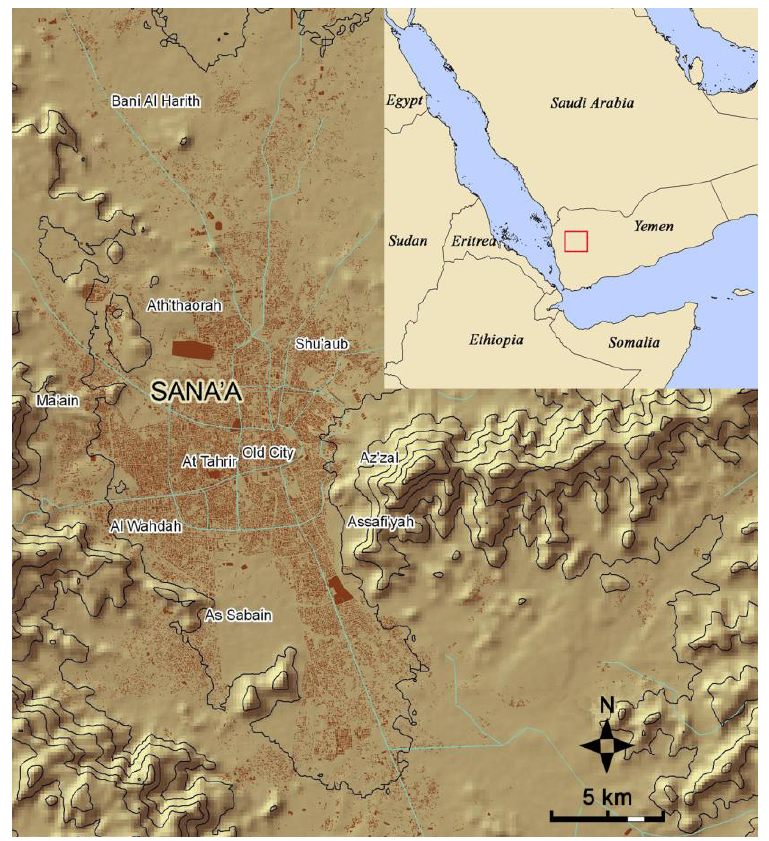
Figure 2. Location of the study